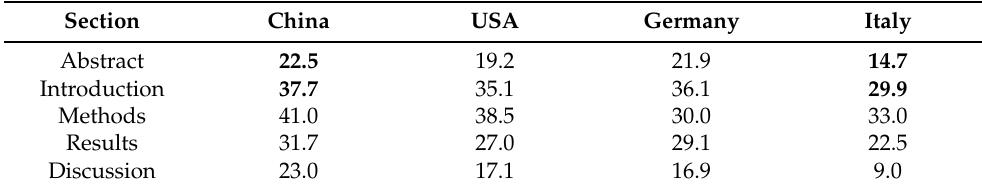
Table 11. Average Flesch Reading Ease scores of article sections from selected